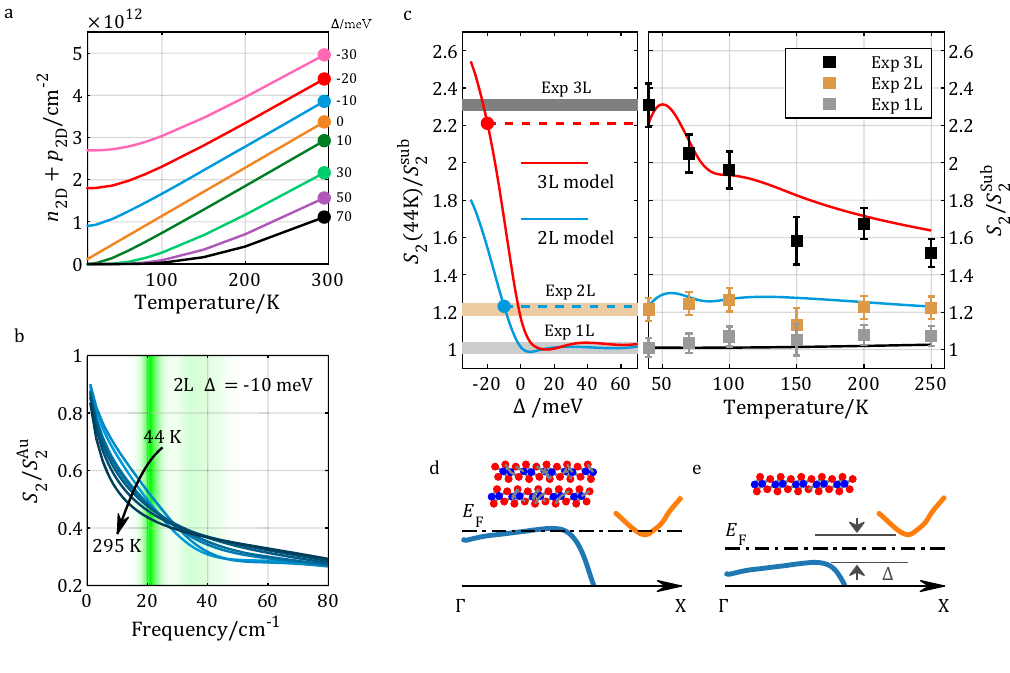
Fig. 4 Near- fi eld electrodynamics of thermally activated carrier of few-layer WTe 2 . a Temperature dependence of thermally activated carrier densities at different gap sizes calculated (Supplementary Note 6) based on the band structure investigated by ARPES [12] . b Near- fi eld spectroscopic response of the thermally activated carriers of a model 2L WTe2 with Δ ¼ (cid:3) 10meV. The green shaded region represents the power spectrum of the THz probe. c Right panel: temperature dependent WL signal calculation based on LRM for 1L (black curve), 2L (blue curve), and 3L (red curve) WTe 2 with gap sizes 60 meV, − 10 meV, and − 20 meV respectively. Along with the model, nano-THz data of 1L, 2L, and 3L WTe 2 are displayed with squares. The error-bars are the standard deviations of the extracted data in regions indicated in Fig. 2b. Both the model curves and experiment points are normalized to the substrate value. Left panel: the gap-size dependent near- fi eld signal of 2L (blue) and 3L (red) at 44 K. The signal level is strongly suppressed when the gap is close to zero or positive. d , e Hypothetical band structure of semimetallic 2L WTe 2 (left) and insulating 1L WTe 2 [12] with a bandgap Δ > 60meV